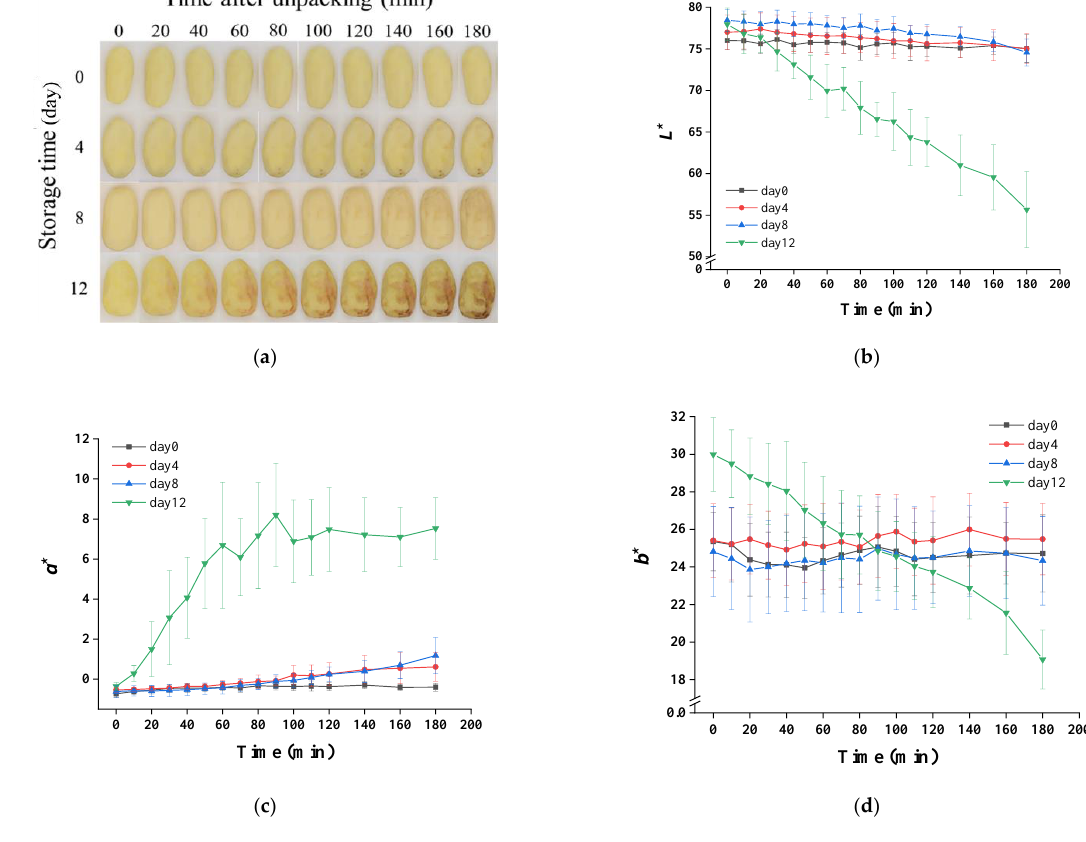
Figure 4. Changes of visual quality ( a ) and the values of L * ( b ), a * ( c ) and b * ( d ) of vacuum-packaged peeled potatoes during storage within 180 min after unpacking.